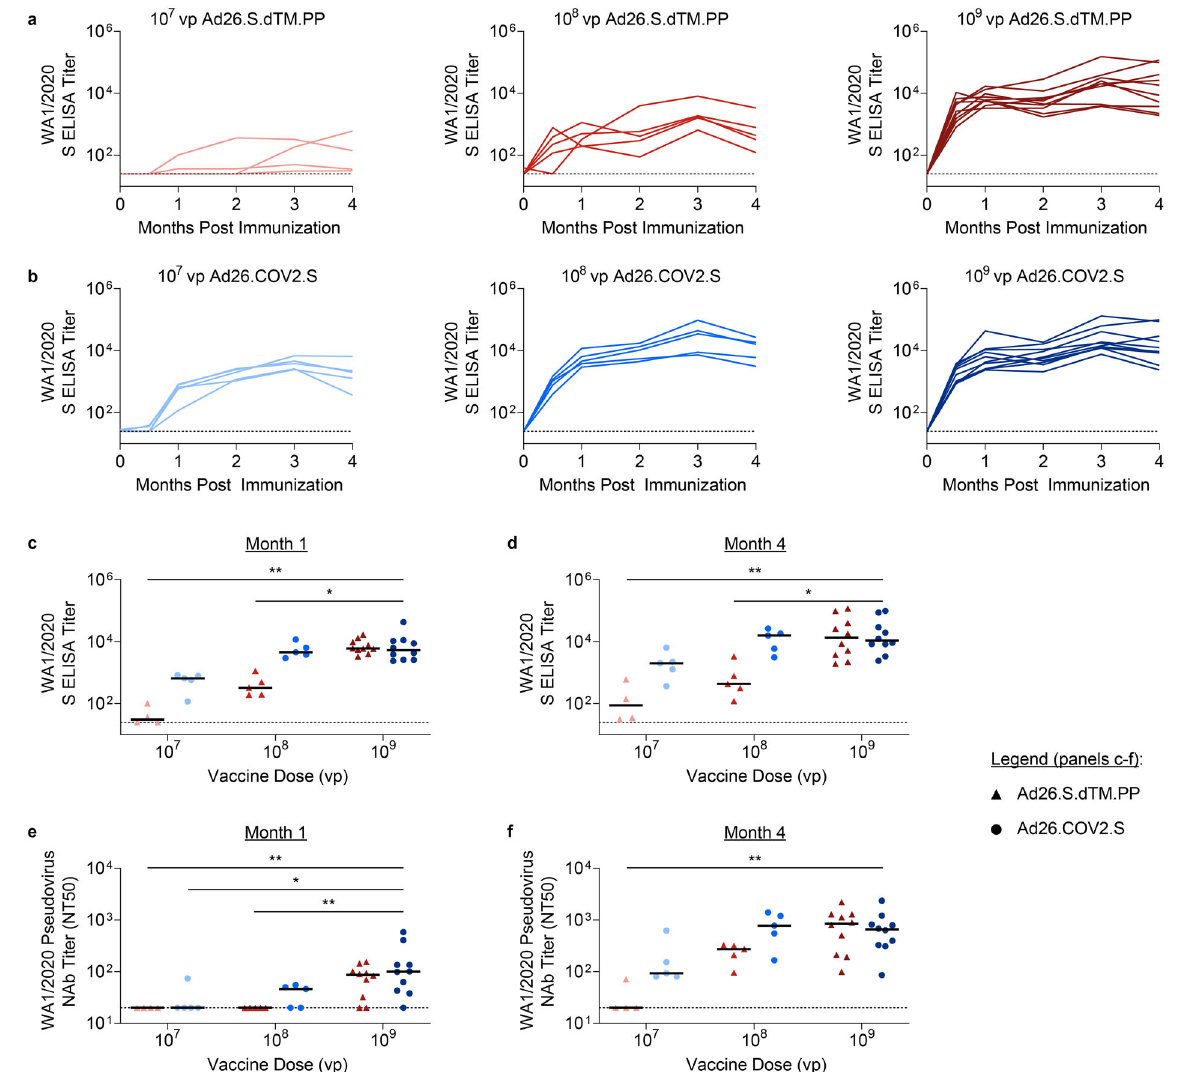
Fig. 1 Comparison of humoral responses elicited by two candidate Ad26 vaccines. Binding antibody responses were assessed by WA1/2020 S-speci fi c ELISA at weeks 0, 2, 4, 8, 12, and 16 in mice immunized with 1 × 10 7 ( N = 5), 1 × 10 8 ( N = 5), or 1 × 10 9 ( N = 10) viral particles (vp) of ( a ) Ad26.S.dTM.PP or ( b ) Ad26.COV2.S. Binding antibody responses of Ad26.S.dTM.PP (triangles) and Ad26.COV2.S (circles) immunized mice are displayed at ( c ) 1 month and ( d ) 4 months postimmunization. Similarly, neutralizing activity of vaccine-elicited antibody responses are displayed as the 50% neutralization titer (NT50) at ( e ) 1 month and ( f ) 4 months postimmunization. Horizontal bars re fl ect median titers. Dotted lines re fl ect assay limit of quanti fi cation. P values re fl ect Kruskal Wallis tests with Dunn ’ s multiple comparisons (* P < 0.05; ** P < 0.01; *** P <